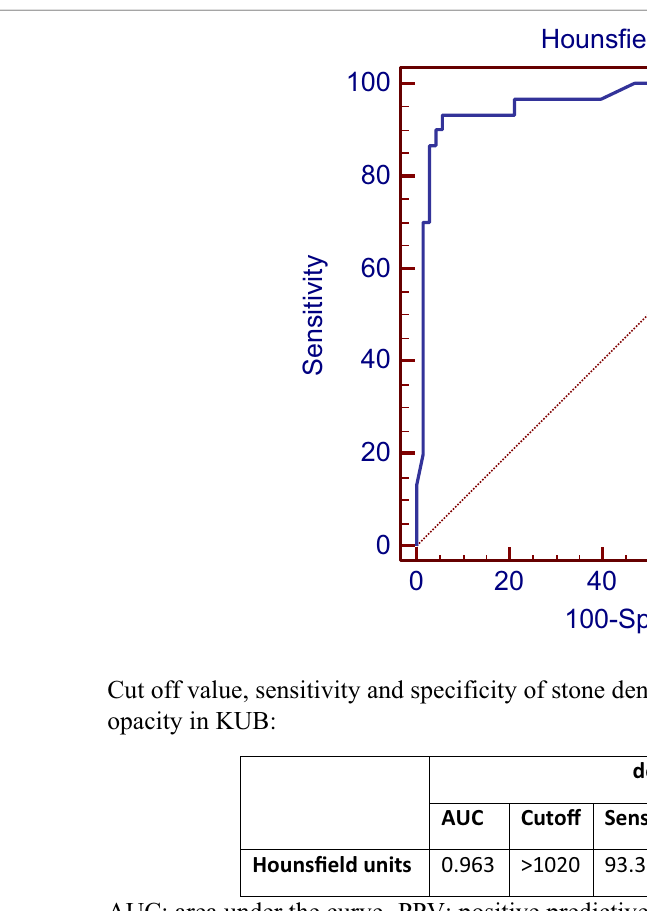
Fig. 1 ROC curve of dense opacity in PKUB about density in Hounsfield